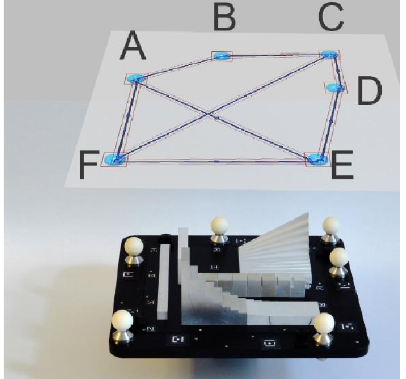
Figure 1 The portable metric test object. Base plate with calibrated spheres as datum and geometrical features to conduct dimensional tolerancing tests and geometric evaluation. Inserted is the secondary plate with geometric features.